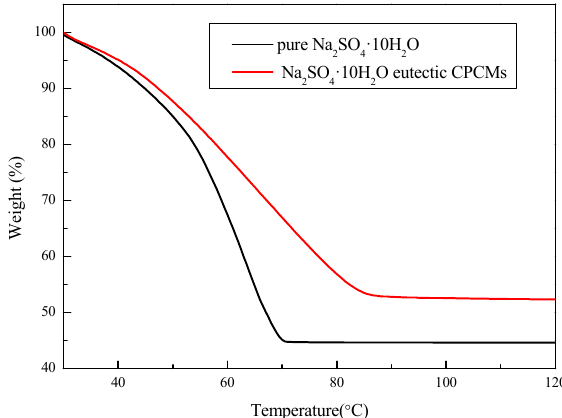
Figure 17. TGA curves of the pure Na 2 SO 4 ·10H 2 O and Na 2 SO 4 ·10H 2 O eutectic CPCMs.